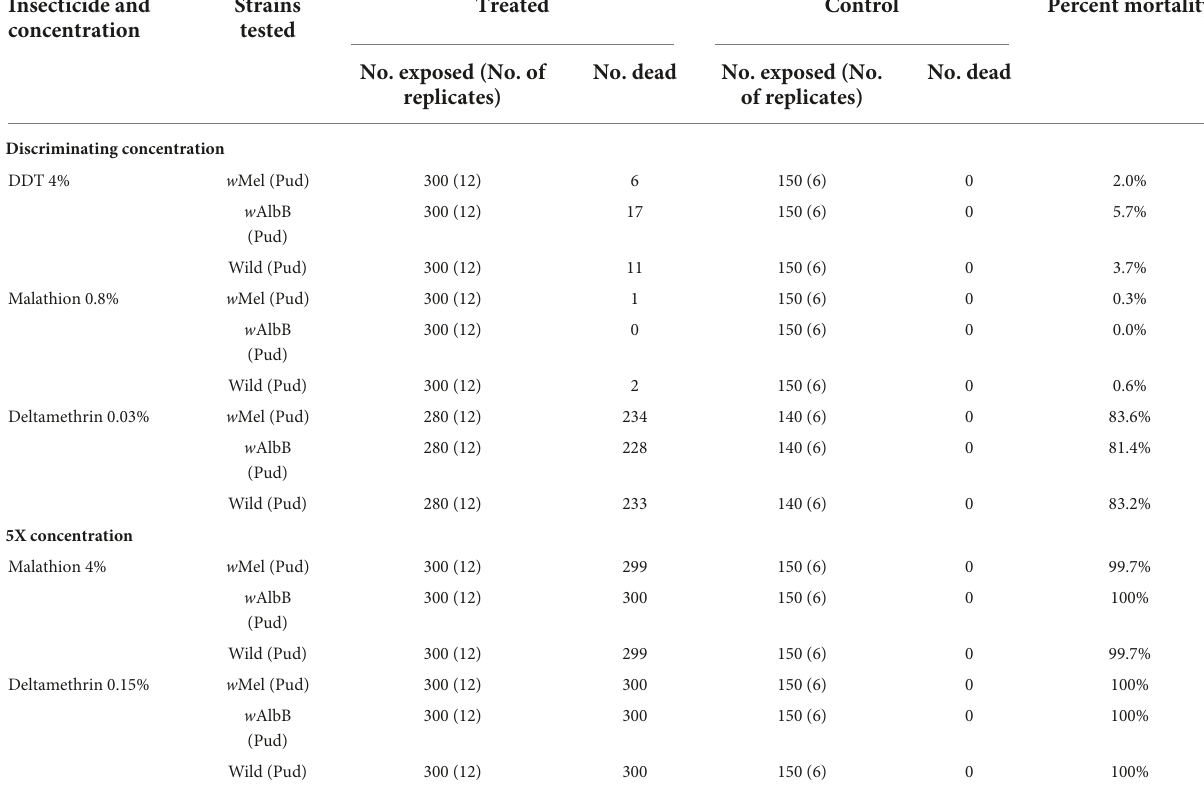
TABLE 5 Percent mortality of w Mel and w AlbB Ae. aegypti (Pud) lines and wild Ae. aegypti (Pud) females on exposure to discriminating/5x concentrations of public health insecticides. Insecticide and Strains Treated Control Percent mortality concentration tested No. exposed (No. of No. dead No. exposed (No. replicates) of